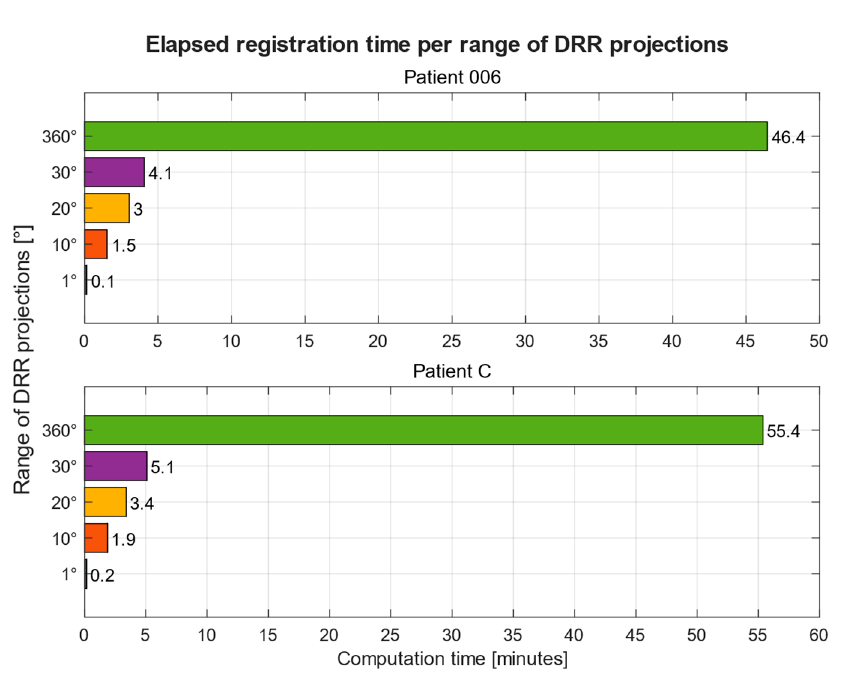
Figure 12. Computation times in minutes of image registration per range of rotation angles of DRR projections for two patient datasets. Acquired on PC 1.